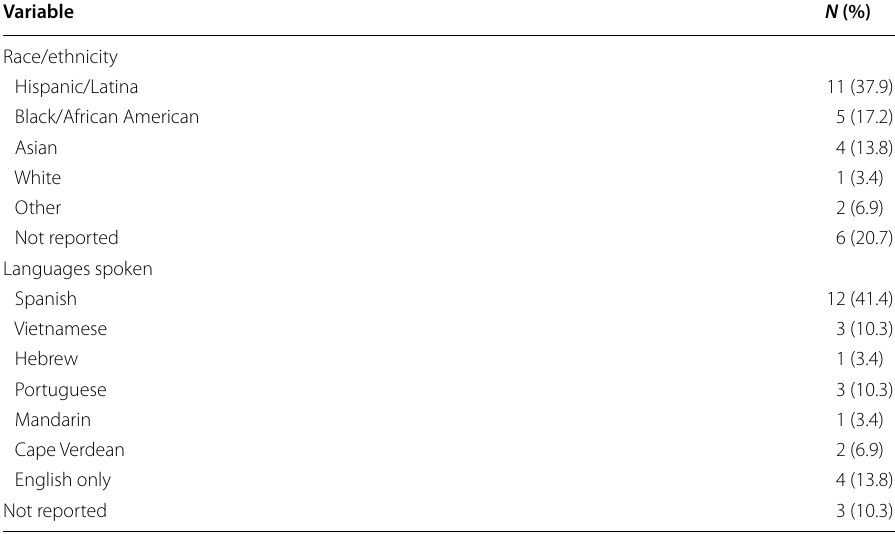
Table 3 Demographic information of parent leader study participants ( N